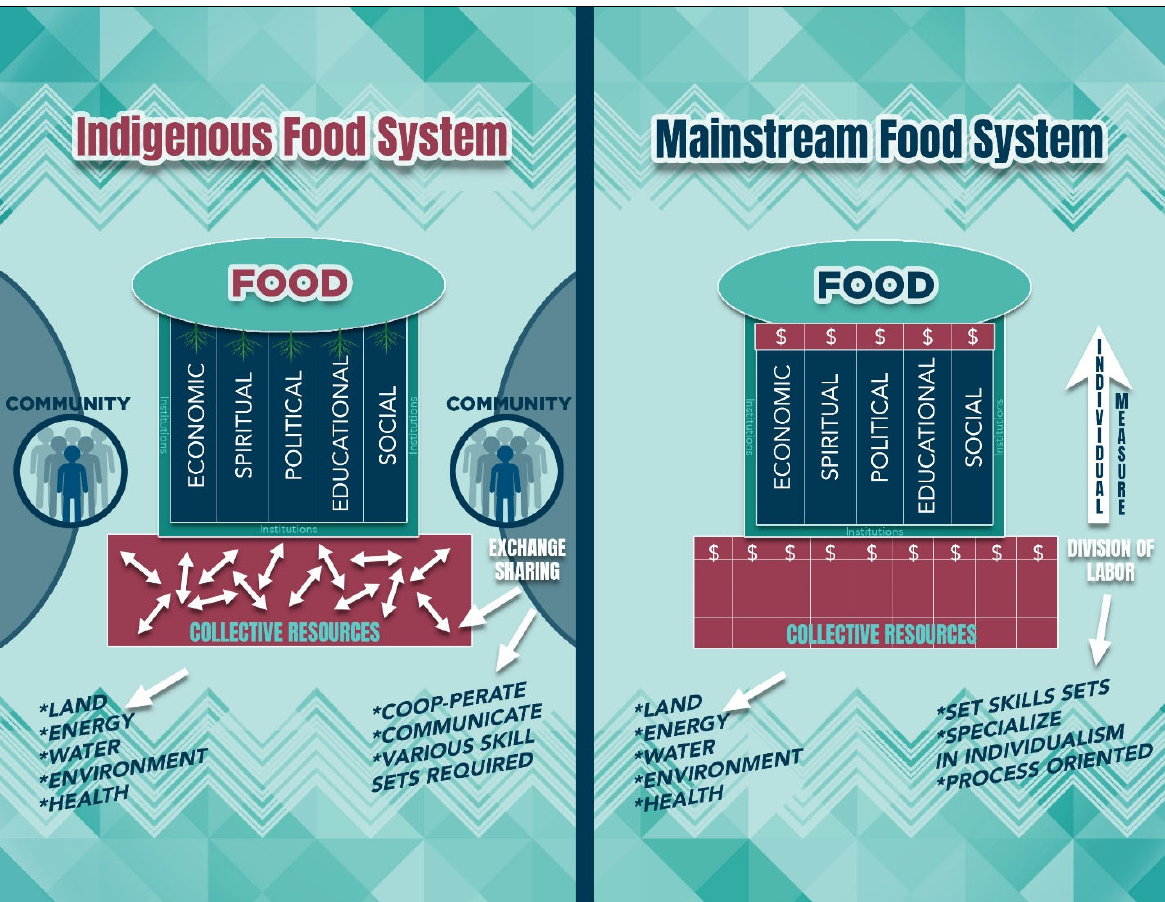
Figure 1. Indigenous and Mainstream Food Systems Compared